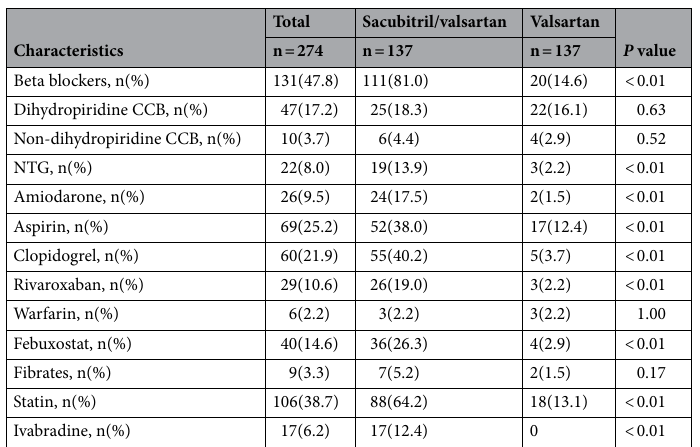
Table 3. Baseline medication profiles of the cohort. CCB calcium channel blocker, NTG nitroglycerin.